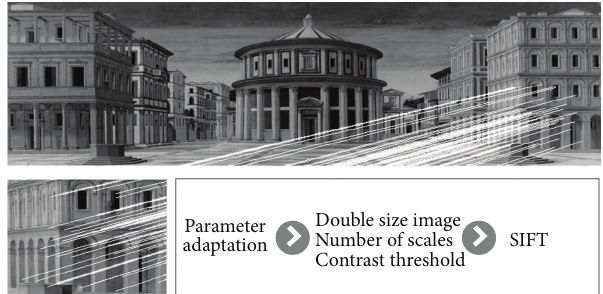
Figure 5: Adaptive SIFT approach. Feature extraction parameters are adapted to the processed image and then the SIFT algorithm is